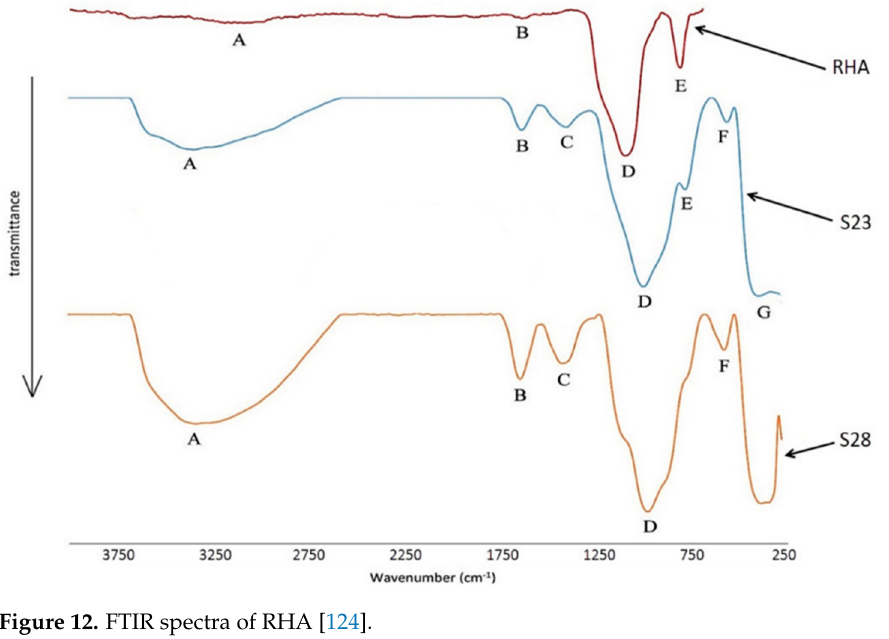
Figure 12. FTIR spectra of RHA [124].